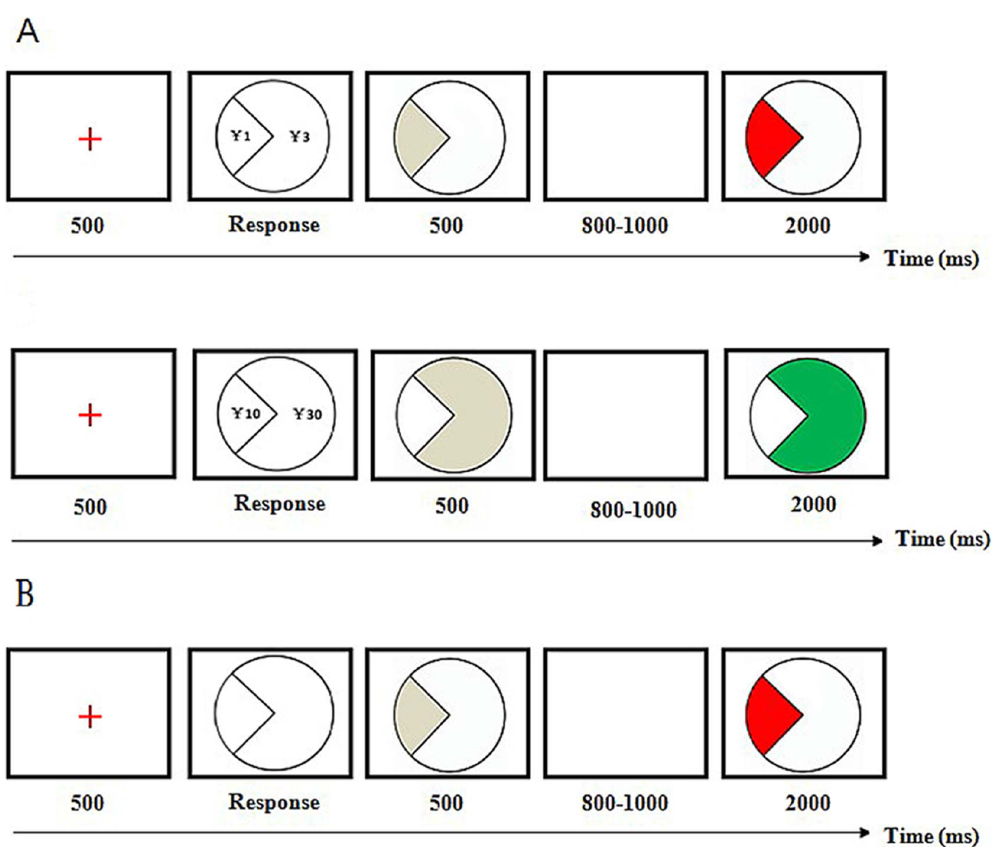
Figure 1. Sequence of stimuli in a typical trial. Time (ms) represents stimulus duration. (A) Tasks in low amount (¥4) context (upper panel) and in high amount (¥40) context (lower panel) in Experiment 1; (B) Task in Experiment 2.